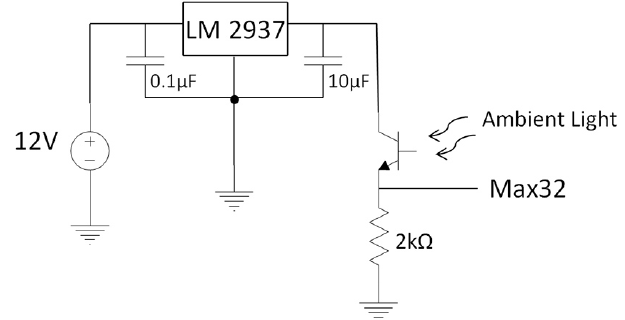
Figure 3. Simplified schematic showing excitation voltage applied to the phototransistor collector, the 2 k(cid:127) load resistor, and the sen- sor output as applied to an analog input channel on the microcon- troller.